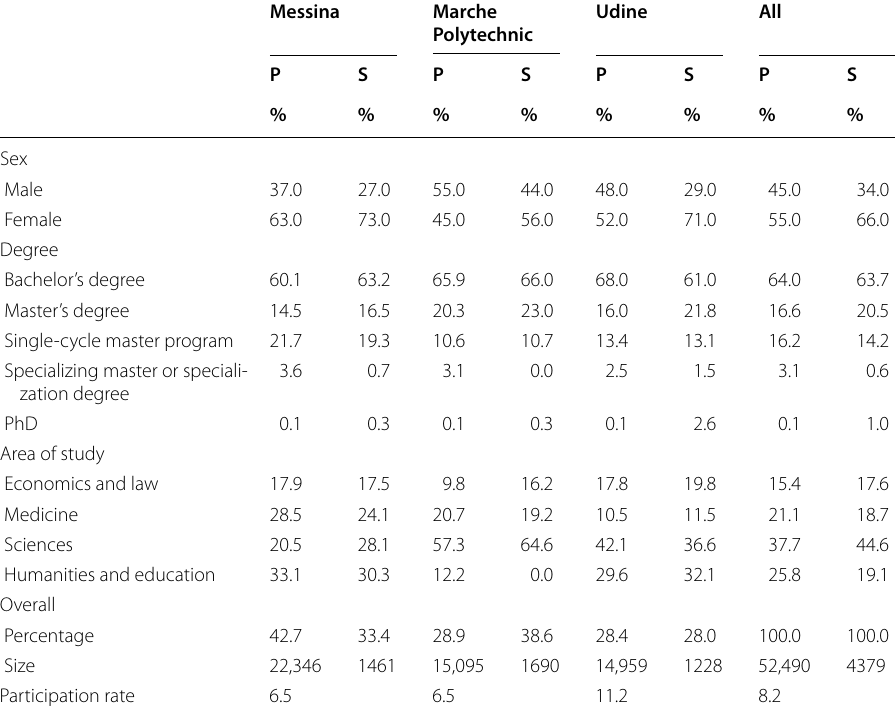
Table 1 Population (P) and sample (S) characteristics Messina Marche Polytechnic